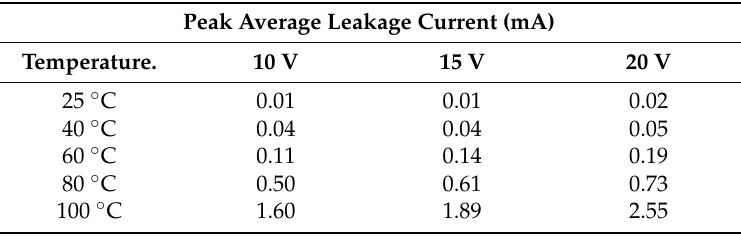
Figure 4. Leakage current of the bypass diode at various temperature and reverse bias voltage: ( a ) 10 V, ( b ) 15 V, and ( c ) 20 V. ( d ) The leakage current of the bypass diode as a function of reverse bias voltage with different surrounding temperatures. Table 1. Measured peak average leakage current.